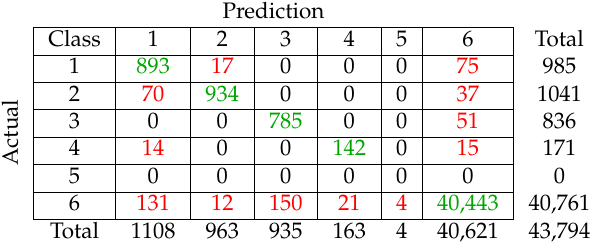
Table 5. Confusion matrix displaying results from the SVM classifier. The green highlighted numbers are true positives, and the red highlighted numbers are false positives.